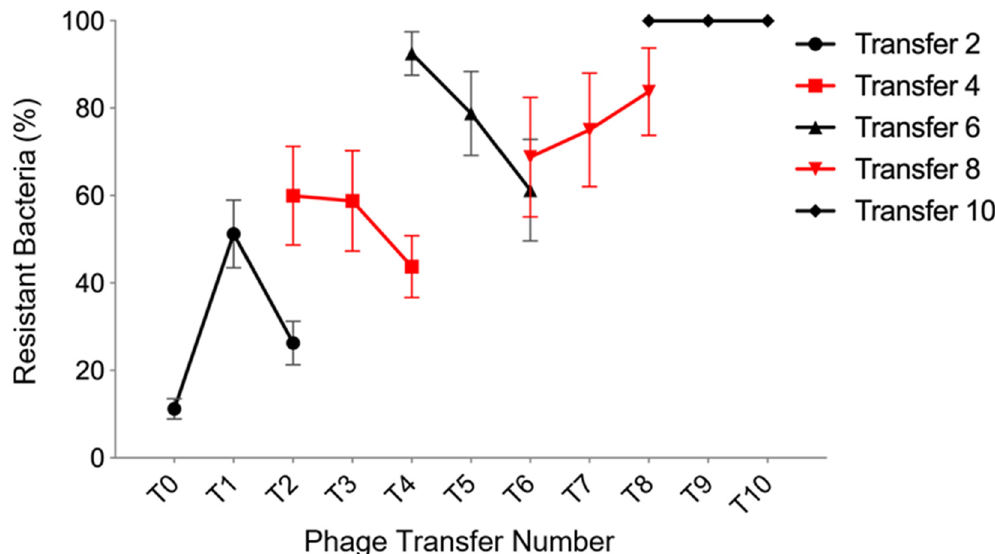
Figure 2. Rate of evolution of phage φ NV3 through time. The experimental coevolution was performed by inoculating King’s medium B (KB) with phage φ NV3 and Pseudomonas agarici NCPPB 2472. After 48 h incubation at 27 ◦ C, both bacteria and phage were recovered and transferred to fresh KB. This was repeated for 10 transfers. Each line represents the resistance of bacteria to past (the previous transfers), current (the present transfer) and future (the subsequent transfers) phage. Values are mean of 5 replicates +/ − SEM.